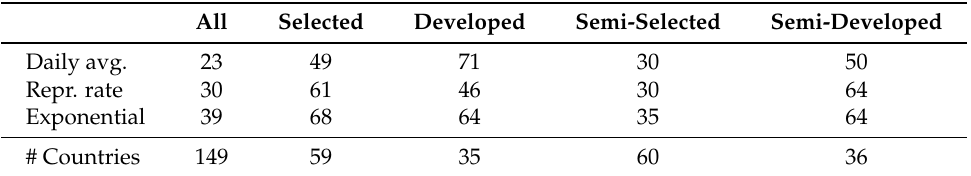
Table 1. The proportion [%] of instances considered positive for each class/country set combination. In addition, the number of countries (and thus the number of instances) in each set is also listed. All Selected Developed Semi-Selected Semi-Developed Daily avg. 23 49 71 30 50 Repr. rate 30 61 46 30 64 Exponential 39 68 64 35 64 # Countries 149 59 35 60